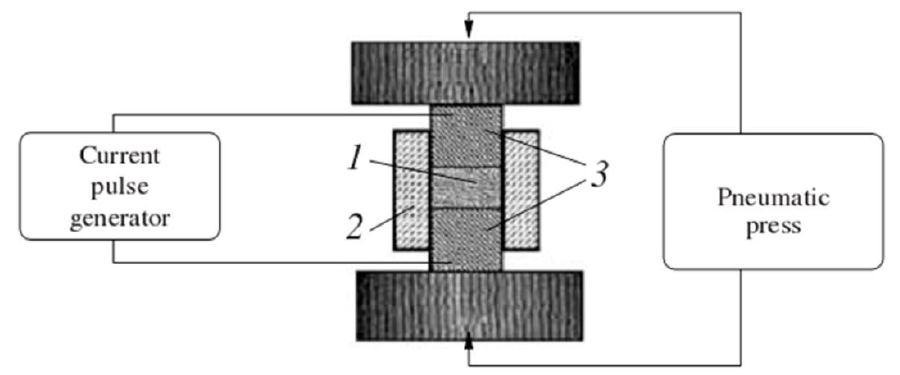
Figure 10. Schematic of an electric pulse sintering set-up.